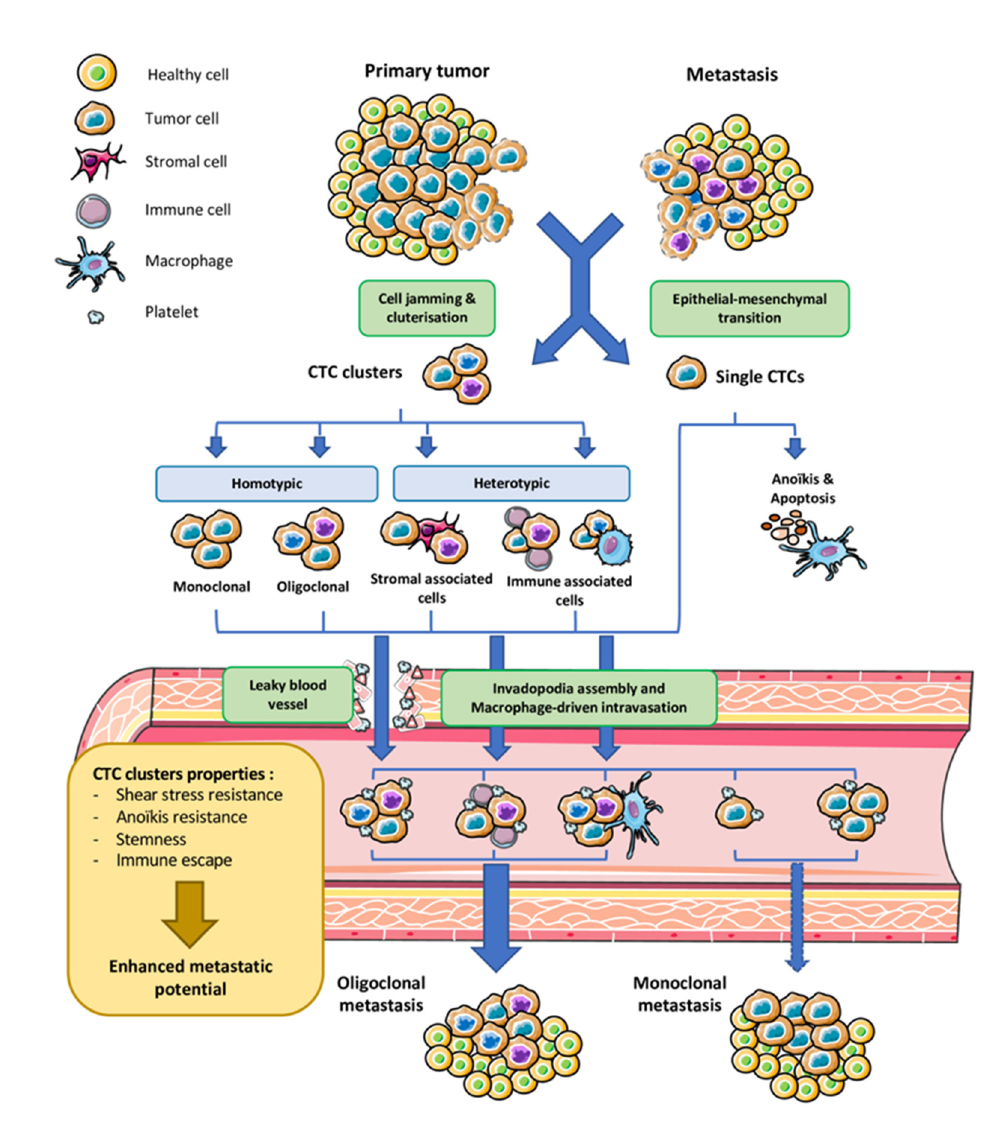
Figure 1. Origin and dissemination of circulating tumor cell (CTC) clusters. Cell aggregates detach from the primary tumor site and metastases by cell jamming to produce homotypic monoclonal or polyclonal tumor clusters. Released cells can also interact with stromal or immune cells in the inflammatory peri-tumoral infiltrate forming heterotypic clusters. Heterotypic cluster formation can also occur in blood vessels by association with circulating immune cells, and possibly with platelets. Intravasation of CTC clusters can occur by invadopodia and macrophage lead or through leaky blood vessels common in tumor microenvironment. In the bloodstream, clustering strengthens CTCs by anoïkis resistance, shear stress resistance, and immune escape and enhances their stemness, resulting in boosted metastatic potential. After extravasation in tissue with favorable microenvironment conditions, clusters can form monoclonal or polyclonal metastasis depending on their initial nature. This figure was performed using free online Servier Medical Art at